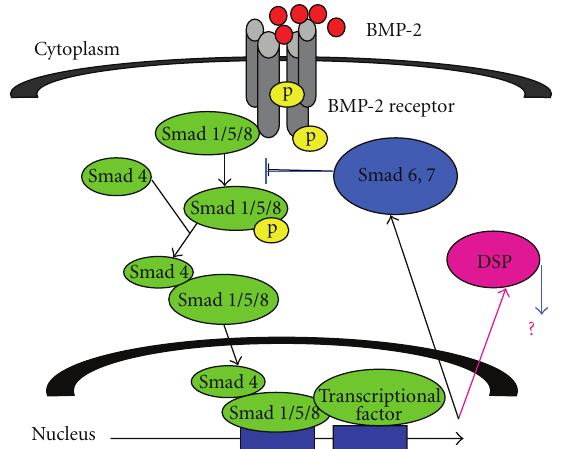
Figure 3: Proposed schema of Smad signaling pathways in KN-3